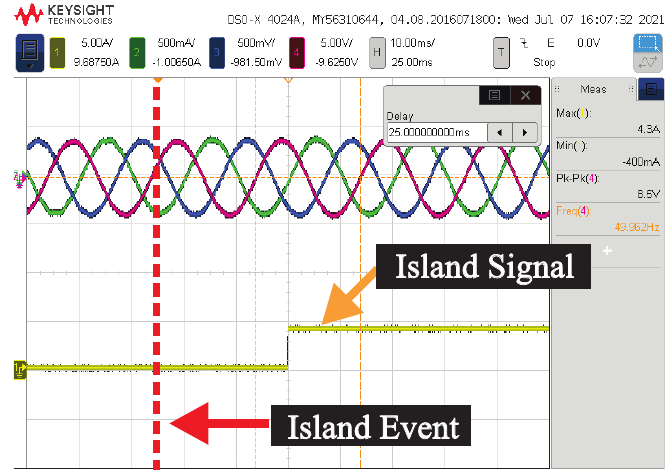
Figure 12. Single load islanding experimental results, detection time: 25 ms.